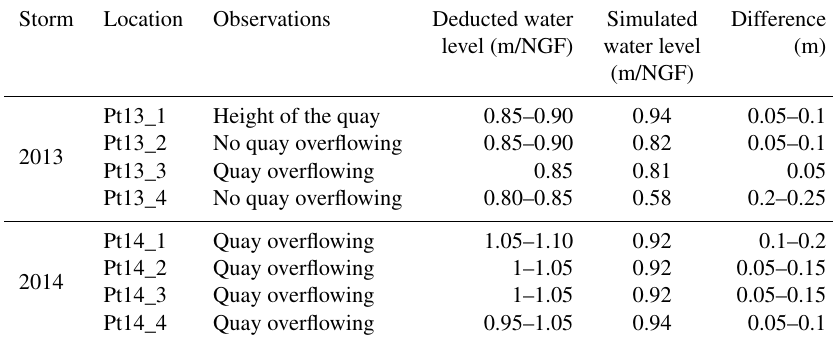
Table 4. Observed vs. simulated water level, qualitative and deduced quantitative